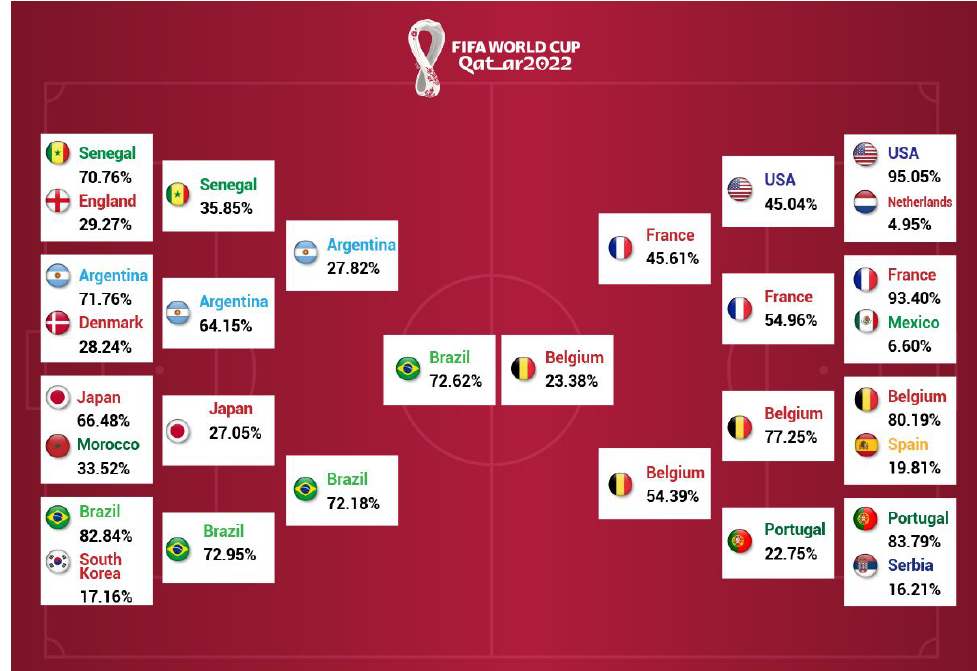
Figure 10. The arrangement mirrors that of Figure